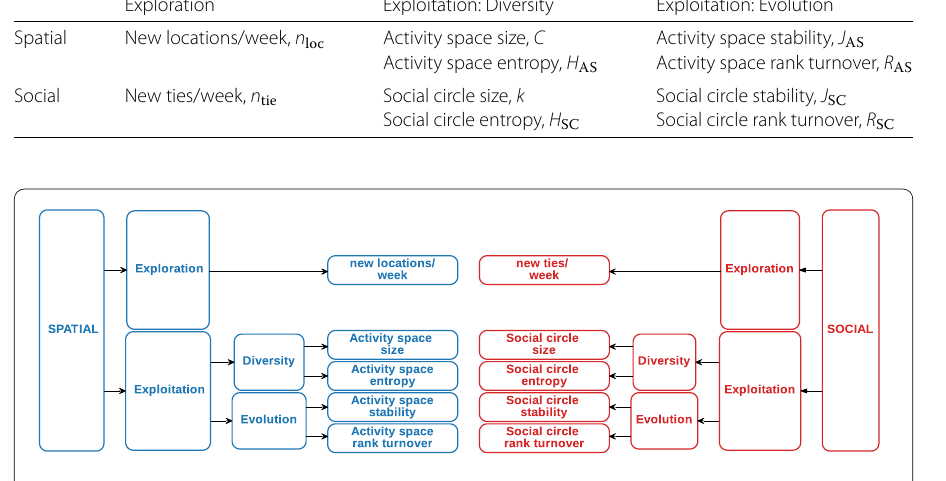
Figure 1 Schematic description of our framework